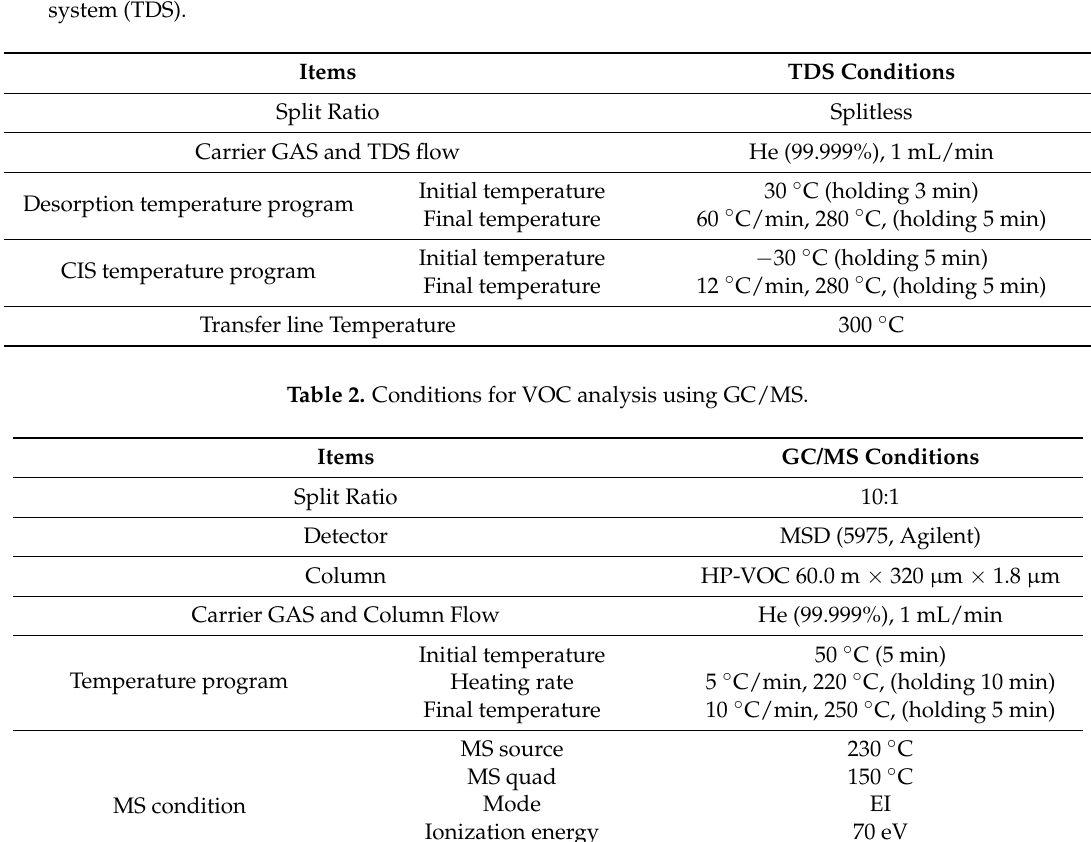
Table 1. Conditions for volatile organic compound (VOC) analysis using a thermal desorption system (TDS).